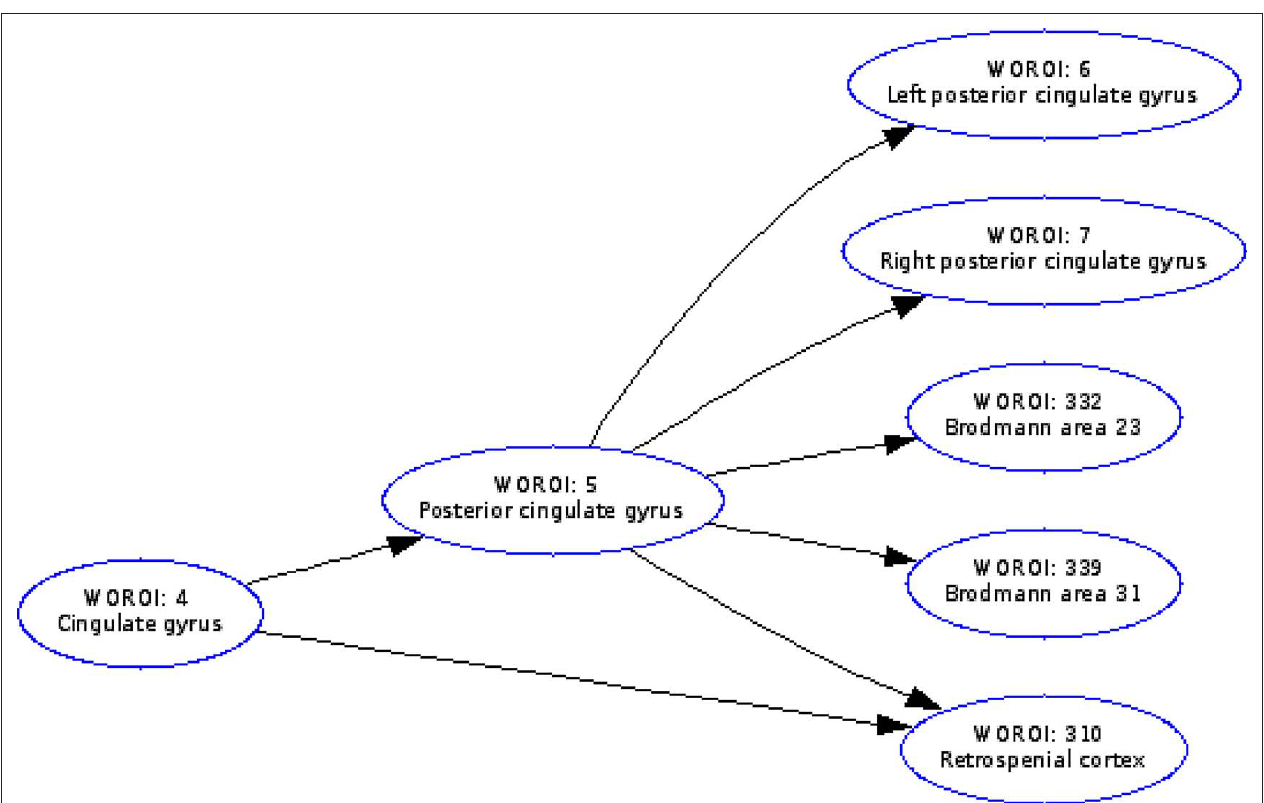
FIGURE 13 | For presenting the Brede Database brain region ontology on the Web the workfl ow with the Brede Toolbox invokes the GraphViz program which generates hyperlinked plots of the brain region hierarchy, here for the ‘posterior cingulate gyrus’.